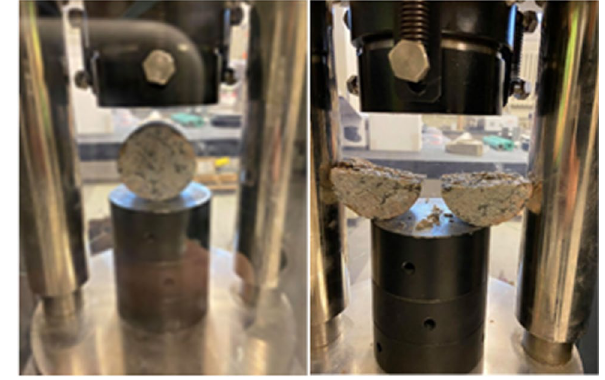
Fig. 3 Brazilian test set-up on a Stanstead granite